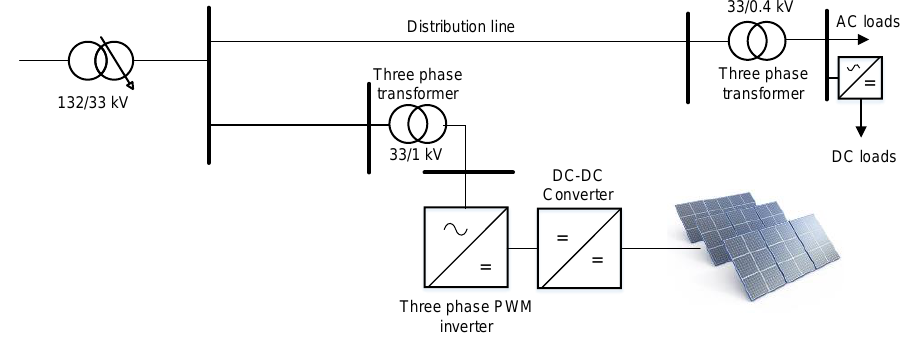
Figure 1: Connection of a large PV array to the distribution network through an AC connection.